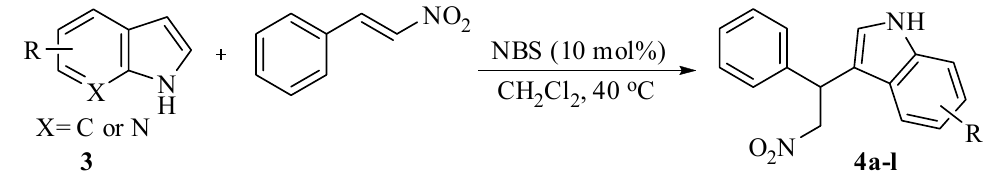
Scheme 3. Reaction of β -nitrostyrene with various indoles and other heterocyclic compounds catalyzed by NBS.